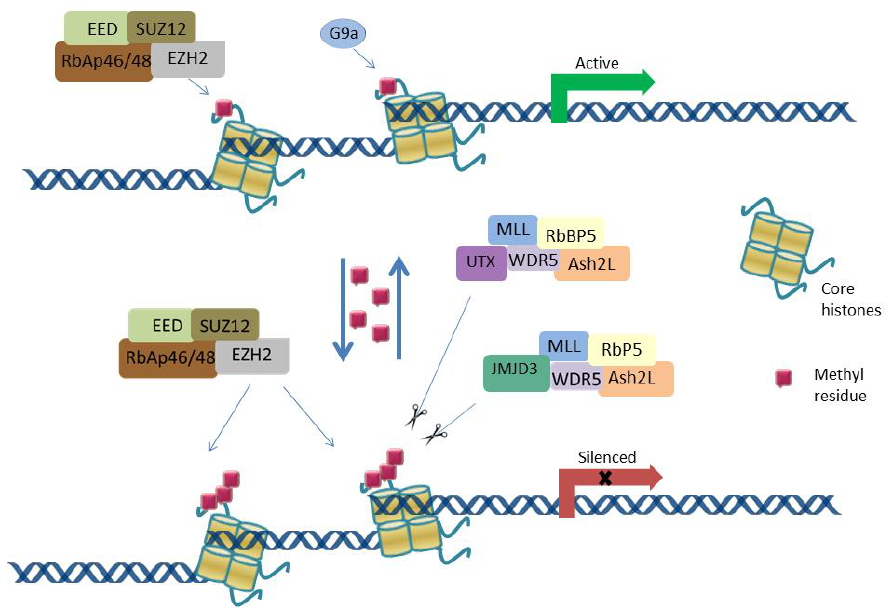
Figure 1. Gene transcriptional regulation via H3K27 methylation. Transcriptional repression regu- lated by the polycomb repressive complex 2 (PRC2) including EED, SUZ12, RbAP46/48, and EZH2, which catalyzes H3K27 mono-, di- and tri-methylation. Enrichment of H3K27 trimethylated marks in gene promoters leads to a more condensed chromatin state and transcriptional silencing of tumour suppressor genes, inflammation- and immunological response genes, and epithelial-mesenchymal transition- suppressor genes enabling tumour progression and metastasis. G9a catalyzes monomethy- lation of H3K27. UTX and JMJD3 demethylases form complexes with MLL, RbBP5, and WDR5, and remove methyl groups from H3K27me3, what leads to transcriptionally active chromatin. Core histones presented as golden rollers, methyl groups presented as red squares. EED (embryonic ectoderm development), SUZ12 (suppressor of zeste 12), RbAP46/48 (retinoblastoma suppressor associated protein 46/48), EZH2 (enhancer of zeste homolog 2), G9a (euchromatic histone lysine methyltransferase 2), UTX (ubiquitously transcribed X-chromosome tetratricopeptide repeat protein), JMJD3 (jumonji domain containing-3), MLL (mixed-lineage leukemia), RbBP5 (RB-binding protein 5), WDR5 (WD repeat-containing protein).